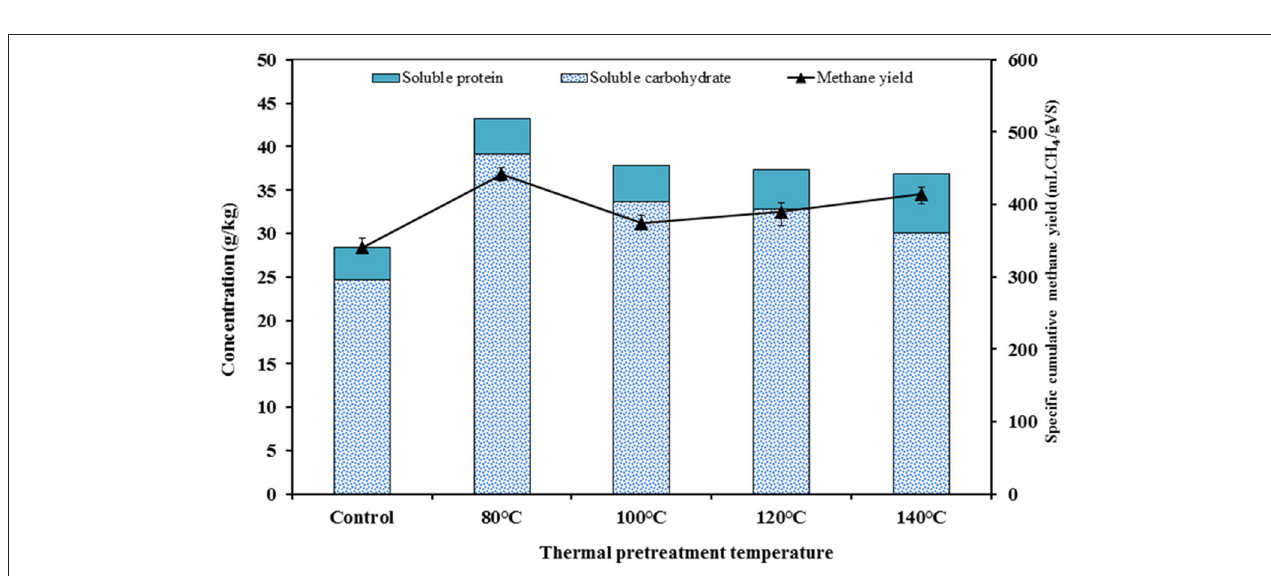
FIGURE 7 | Correlation between the concentration of soluble carbohydrate and soluble protein with the methane yield for each TP